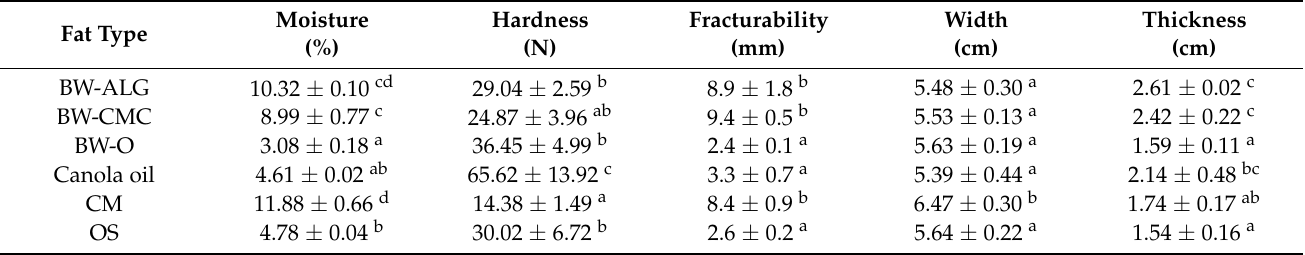
Table 3. Textural characteristics, geometry, and moisture content of cookies prepared from different fats: bigels (BW-ALG and BW-CMC), oleogel (BW-O), canola oil, commercial margarine (CM), and original shortening